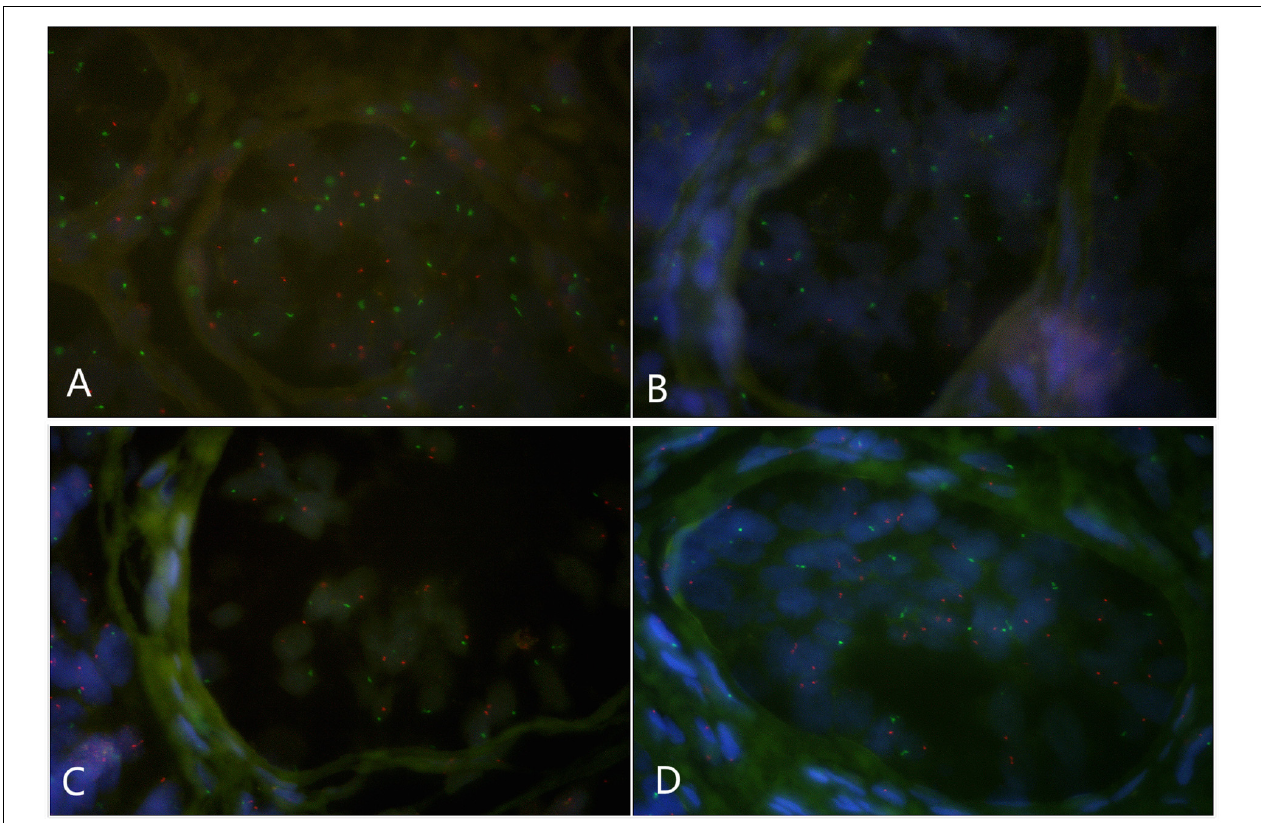
FIGURE 2 | Fluorescence in situ hybridization (FISH) on spermatogenic tubules (green spot: FISH centromeric signals of Chromosome X; red spot: signals of Chromosome Y). (A) A spermatogenic tubule from a normal testicle (NC1553), 23 green and 22 red spots in the tubule implicates XY; BCD: Spermatogenic tubules from A58 testes. In panel (B) , 17 green and 2 red signals detected implicates X/XY mosaicism. In panel (C) , 17 green and 19 red signals detected implicates XY. In panel (D) , 17 green and 34 red signals detected implicates XYY.